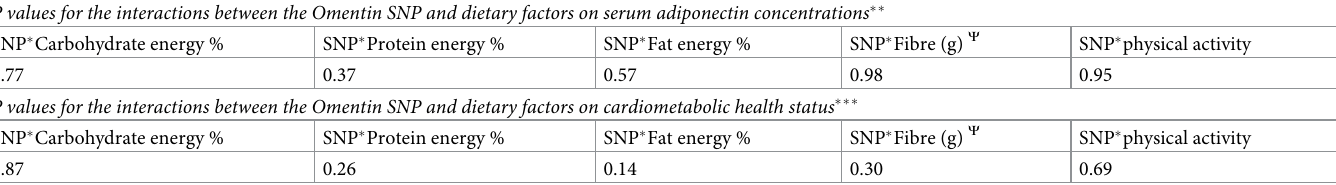
�� P values obtained from linear regression analysis after adjusting for age, sex, body mass index, waist circumference and cardiometabolic health status. ��� Data are p values obtained from logistic regression analysis after adjusting for age, sex, body mass index, waist circumference and adiponectin concentrations. C Adjusted for age, sex, body mass index, waist circumference, adiponectin concentrations and total energy intake. SNP, Single Nucleotide